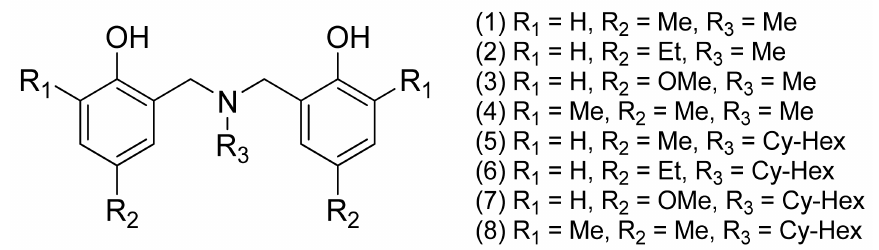
Figure 1. Chemical structure of the dihydro-benzoxazine dimers studied in this